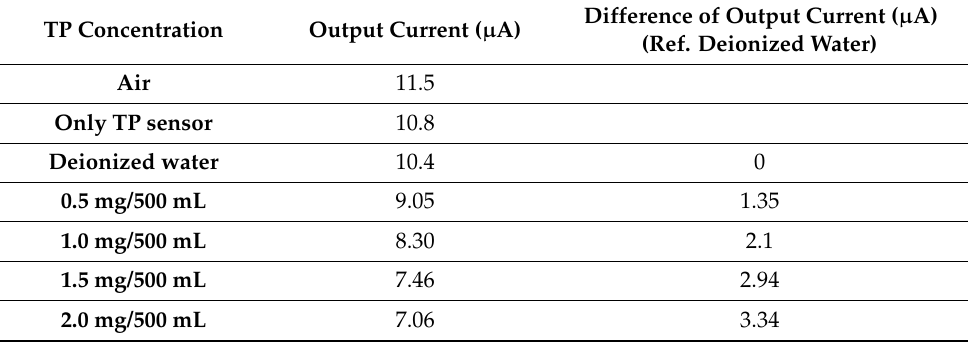
Table 1. Output current and difference of the output current as a function of the TP concentration of the analytes pretreated by the autoclave (i.e., the difference of the output current was calcu- lated by differencing the output current between the DI (without phosphorus) and the analytes (with